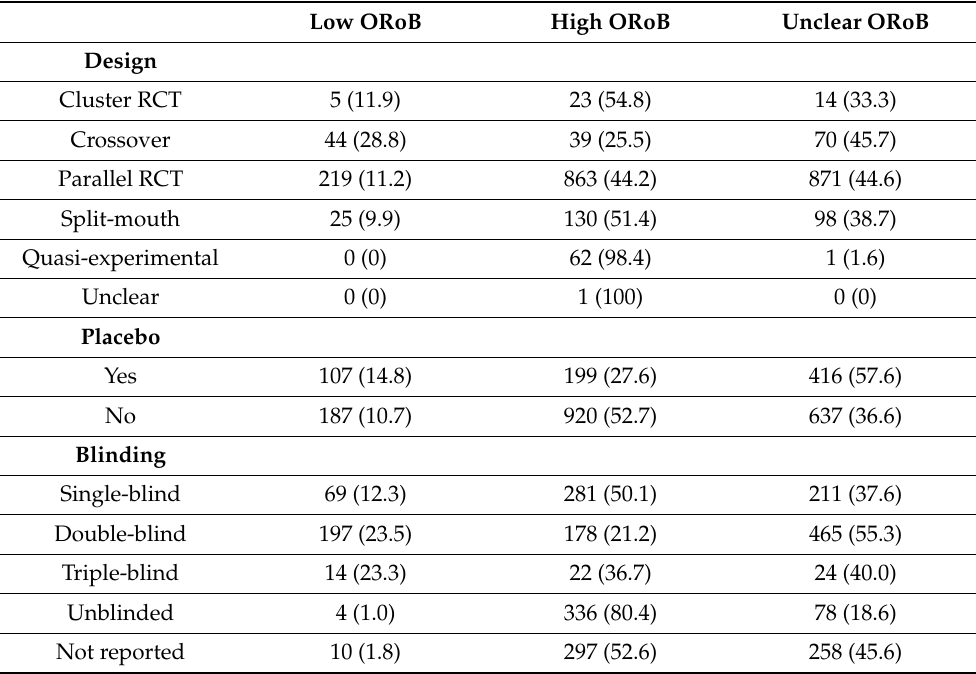
Table 1. ORoB (Overall Risk of Bias) for each study design and method. Low ORoB High ORoB Unclear